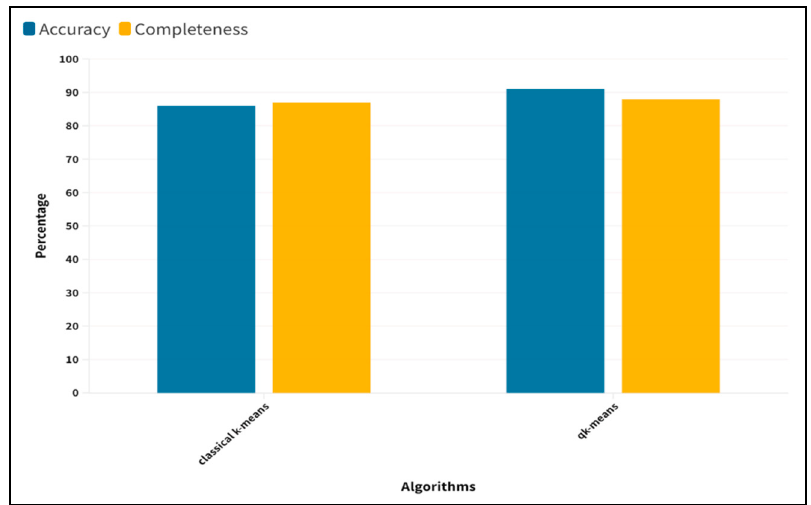
Figure 9. The bar graph shows the result of classical k-means algorithm and QK-means algorithm using the accuracy and completeness metrics on the Mucomycosis dataset.